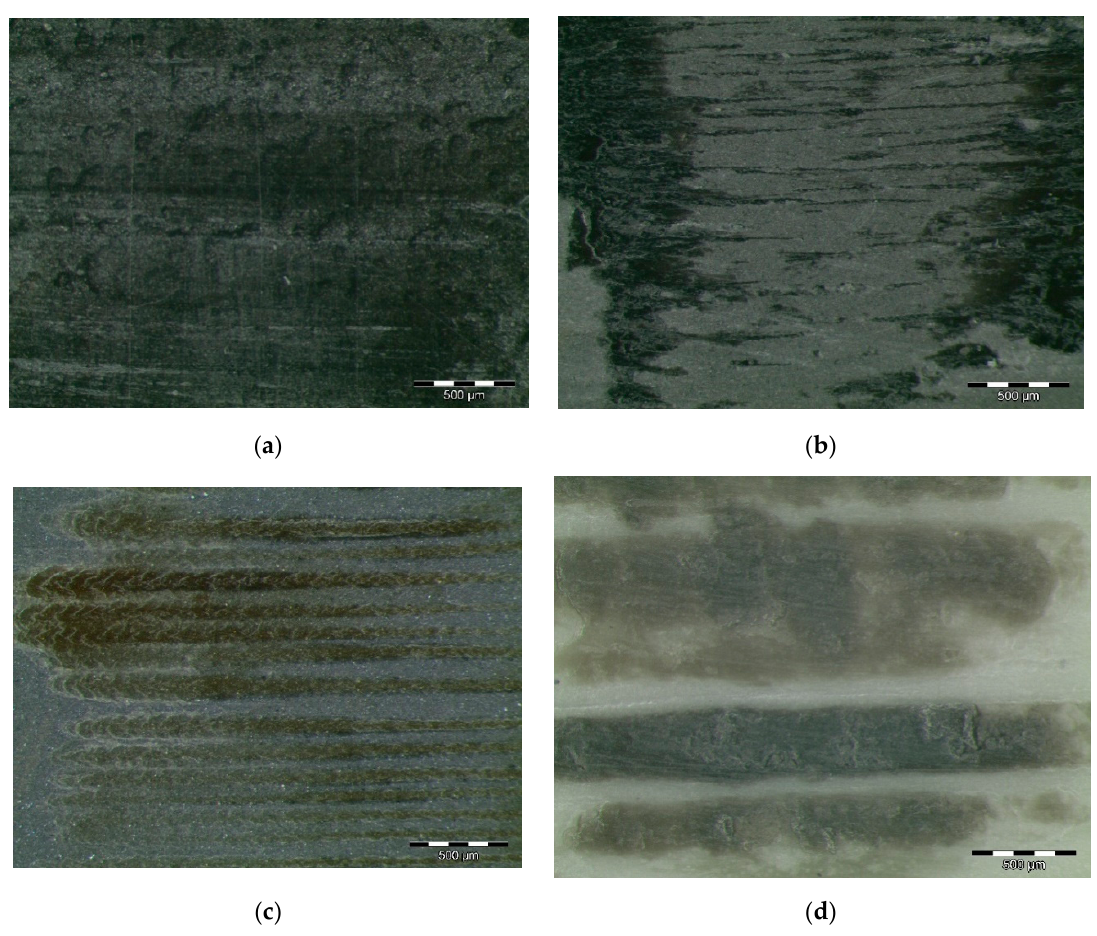
Figure 4. Worn surfaces of PA12 composites: ( a ) PA12 + 5% graphene; ( b ) PA12 + 5% graphite; ( c ) PA12 + 5% MoS 2 ; ( d ) PA12 + 5% ZrO 2 .